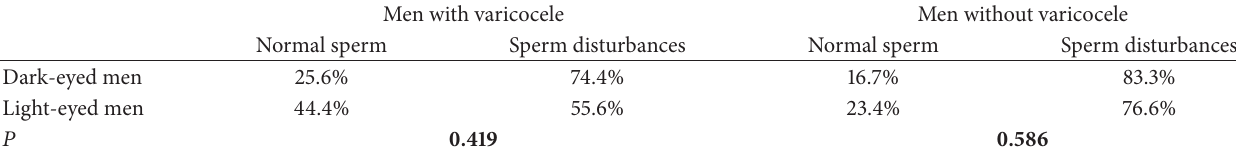
Table 1: Associations between sperm disturbances and eye color in men with or without